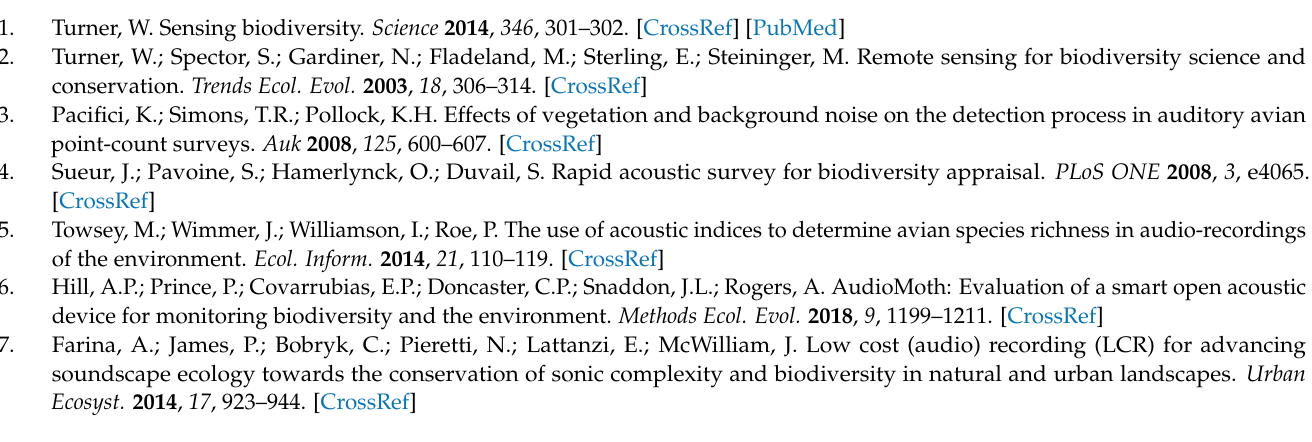
(USA), Table S2: Recording data used in acoustic classifier training, Table S3: Day per recorder of malfunction, Table S4: rank of bird quantification by point-count methods versus passive acoustic recorders, Figure S1: graph of rank